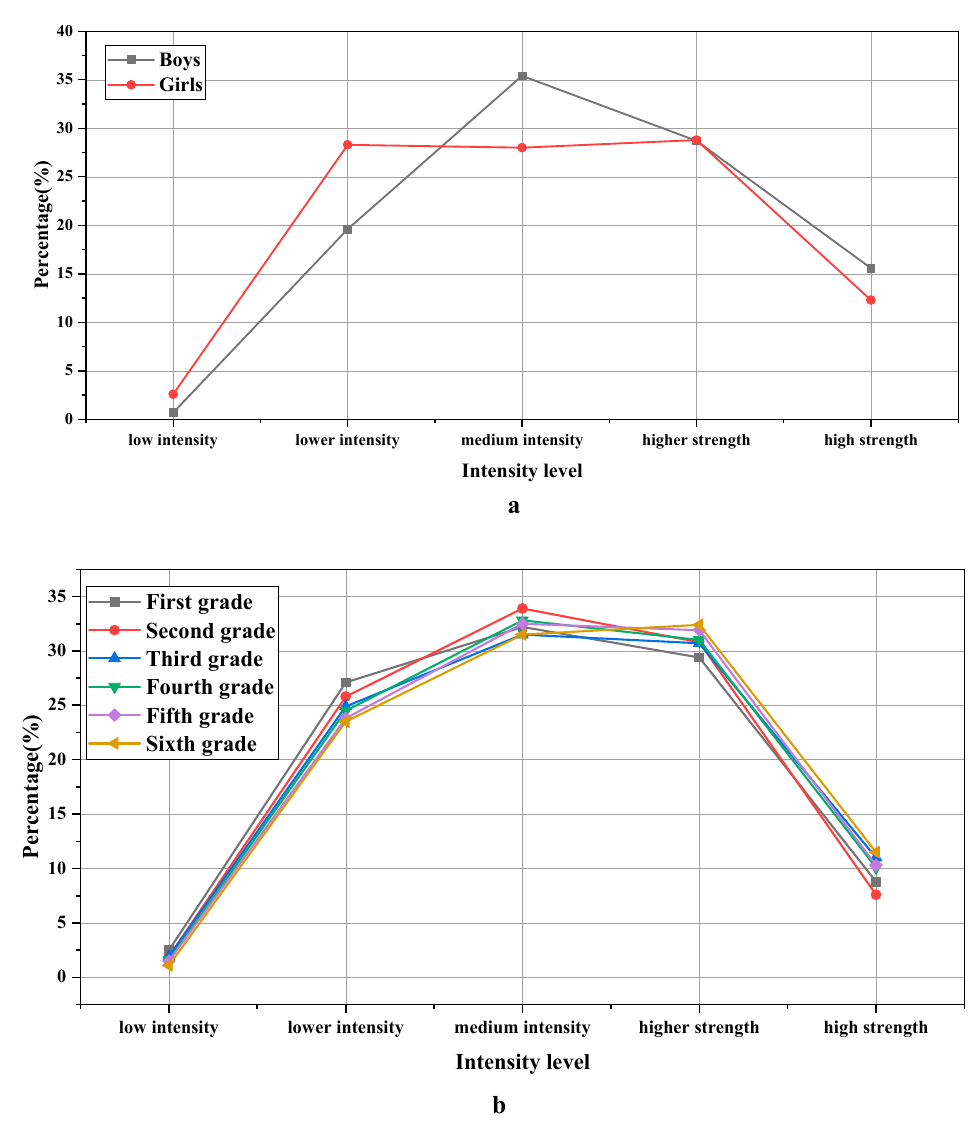
Figure 1. Statistical results of exercise intensity: ( a ) indicates the gender classification of the sample; ( b ) indicates the grade classification of the sample.